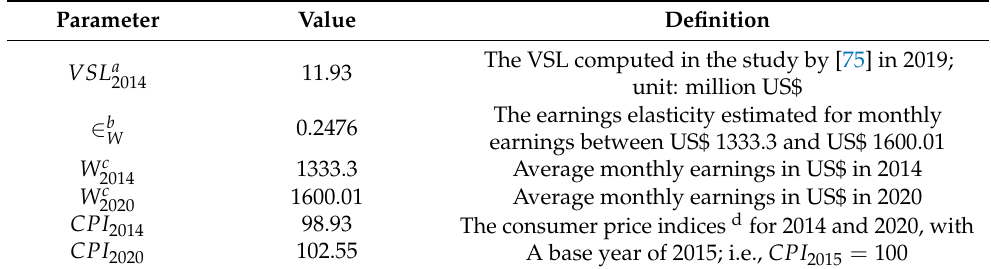
Table 4. All related parameters for VSL